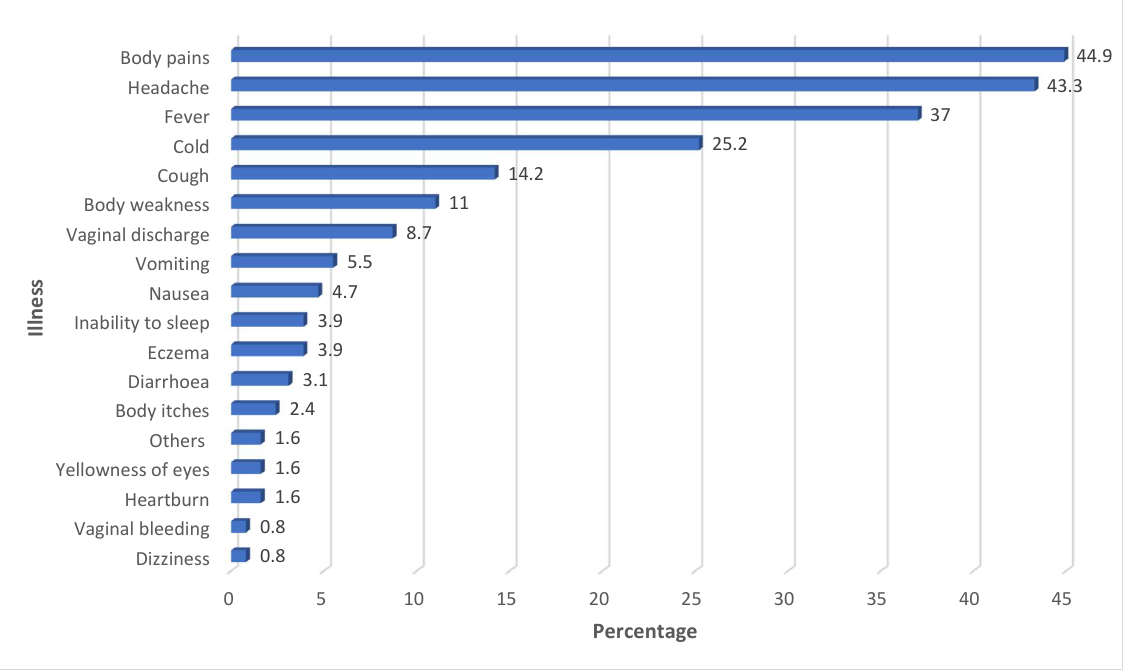
Figure 3. Common illnesses or symptoms that necessitated self-medication.